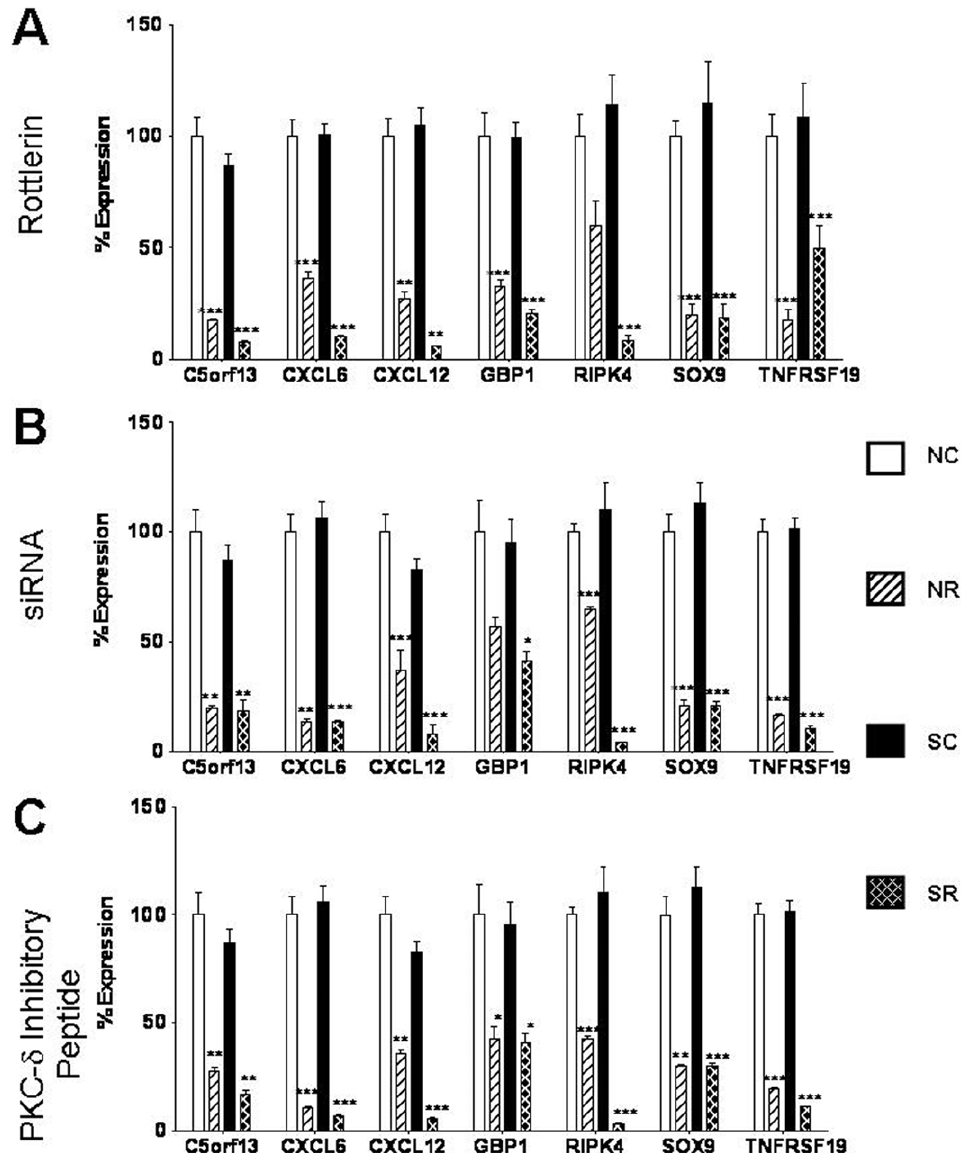
Figure 4. Validation of expression levels of downregulated genes following PKC- d inhibition. A. mRNA expression levels of 7 downregulated genes in normal and SSc human dermal fibroblasts following treatment with A. 5 m M rottlerin, B. 10 nM PKC- d siRNA, C. 10 m M cell permeable specific PKC- d inhibitory peptide for 24 h. Results are expressed as mean percent difference + / 2 SD of 3 replicate samples analyzed by quantitative RT-PCR. The PBS control was arbitrarily set to 100% expression. NC: Normal untreated fibroblasts, NR: Normal treated fibroblasts, SC: SSc untreated fibroblasts, SR: SSc treated fibroblasts. Statistical significance was calculated to compare treated vs untreated normal or SSc fibroblasts. *: p , 0.1; **: p , 0.01; ***: p , 0.0001.